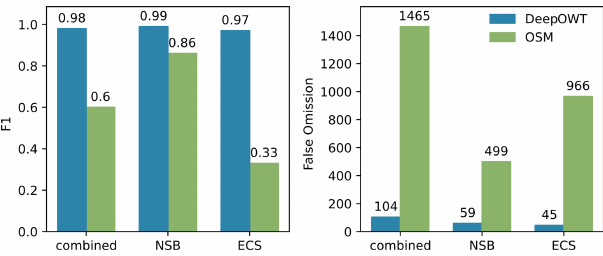
Figure 11. Comparison of the F1 score and false omissions from the OSM and DeepOWT data sets for readily deployed OWT loca- tions in 2019Q4. The data sets were evaluated with the 2019Q4_nsb (North Sea basin) and 2019Q4_ecs (East China Sea) ground truth data sets.